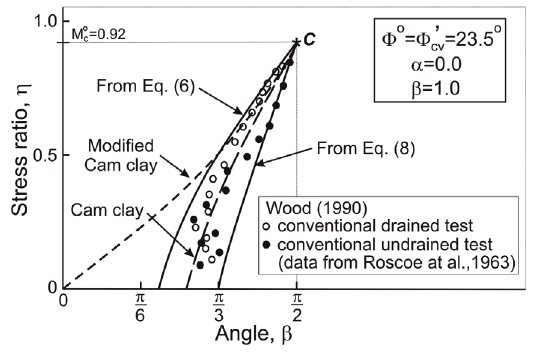
Fig. 9. Stress-dilatancy for spestone kaolin in drained and undrained